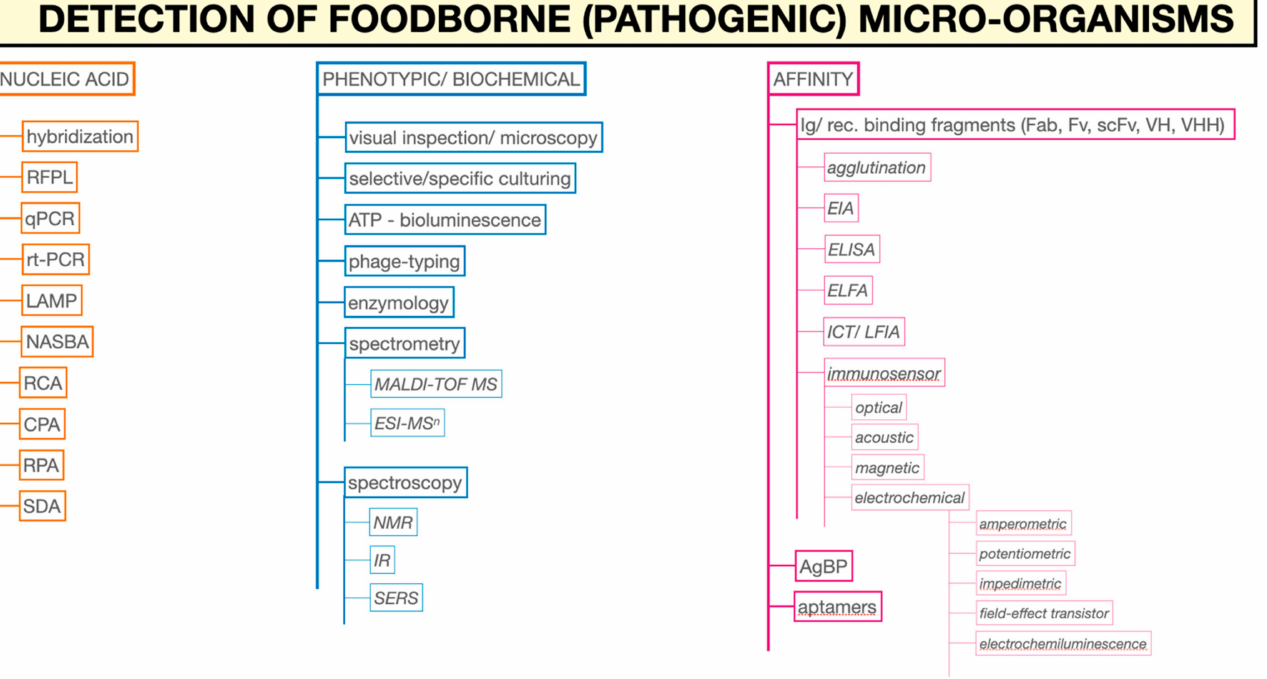
Figure 4. Impression of analytical methods and approaches to find and determine (pathogenic) micro-organisms in the food-chain. It should be noted that electrochemical immunosensors exploit many different detection principles, including amperometry, impedimetry, field-effect transistor (FET), potentiometry. This overview is far from complete. ATP, adenosine triphosphate; AgBP, antigen-binding proteins (not immunoglobulin related); CPA, cross-priming amplification; EIA, enzyme immunoassay; ELFA, enzyme-linked immunofluorescent assay; ELISA, enzyme-linked immunosorbent assay; ESI, electro-spray ionization; Ig, immunoglobulin; IR, infra-red; GC, gas-chromatography; ICT, immunochromatographic test; (RT-)LAMP, (reverse transcription) loop-mediated isothermal amplification; LFIA, lateral flow immunoassays; MALDI-TOF, matrix-assisted laser-desorption ionization time-of-flight; MS, mass-spectrometry; MS n , multi-stage MS; NASBA, nucleic acid sequence-based amplification; NMR, nuclear magnetic resonance; qPCR, quantitative (real-time) polymerase chain reaction; RCA, rolling circle amplification; rec. binding fragments, parts of immunoglobulins obtained by recombinant DNA protein engineering; RPA, recombinase polymerase amplification; rt-PCR, reverse transcription-polymerase chain reaction; SDA, strand displacement amplification; SERS, surface-enhanced